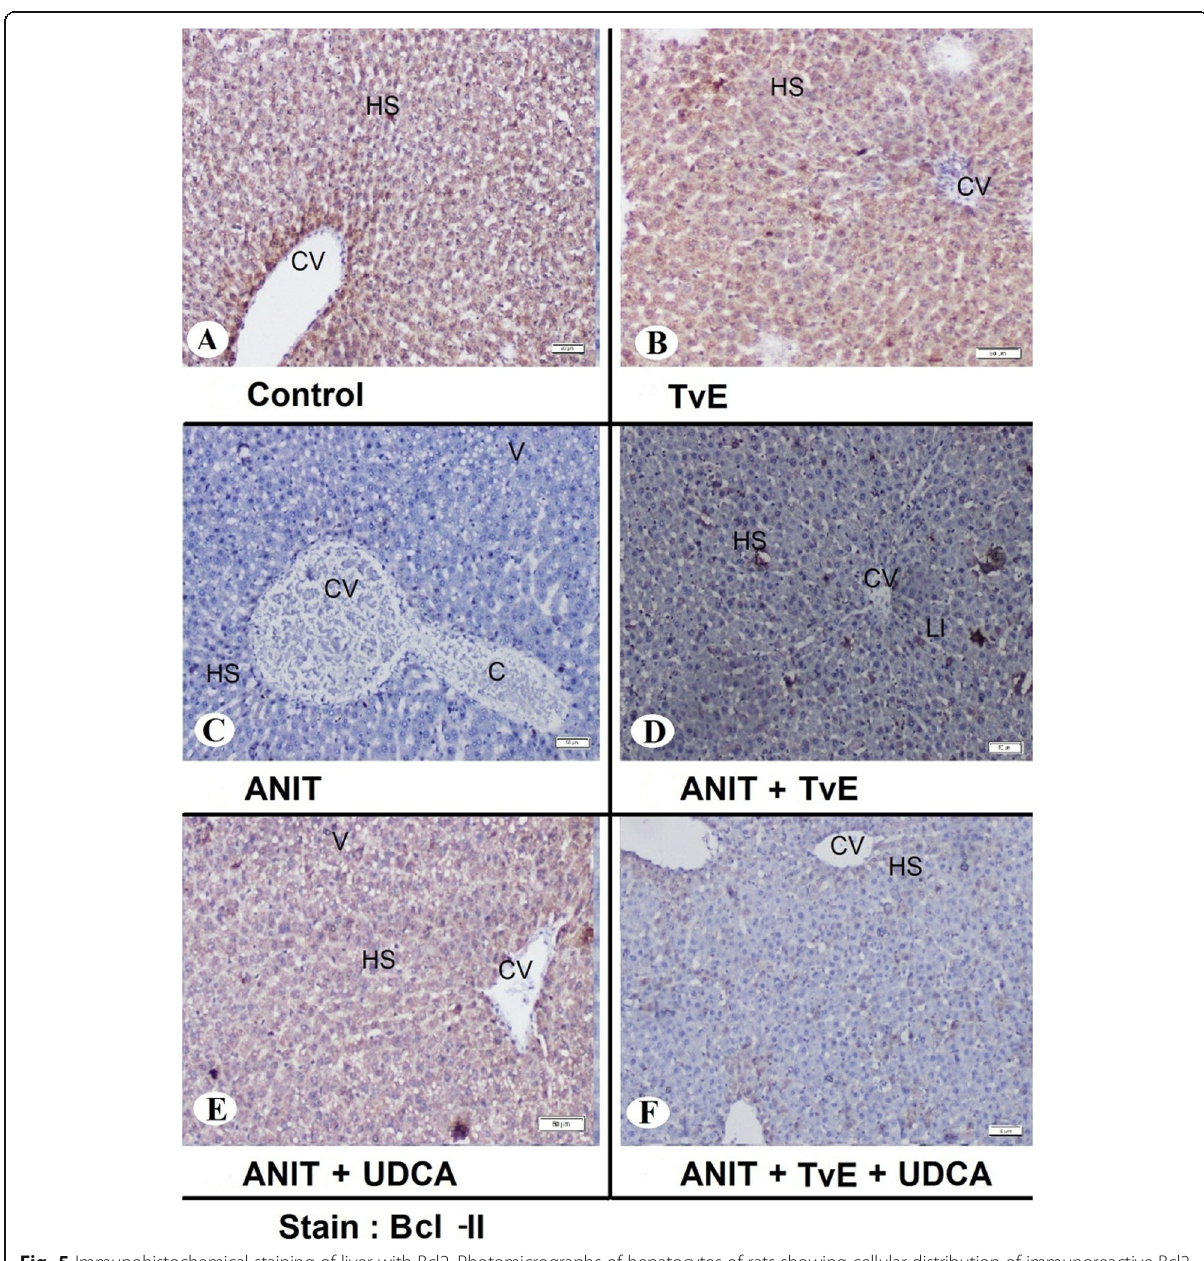
Fig. 5 Immunohistochemical staining of liver with Bcl2. Photomicrographs of hepatocytes of rats showing cellular distribution of immunoreactive Bcl2 protein as indicated by brown color. a Control group showing strong positive reaction. b TvE group showing strong positive reaction. c ANIT group showing weak reaction. d ANIT + TvE group showing strong positive reaction. e ANIT + UDCA group showing strong positive reaction. f ANIT + TvE + UDCA group showing weak reaction. Scale bar = 50 μ